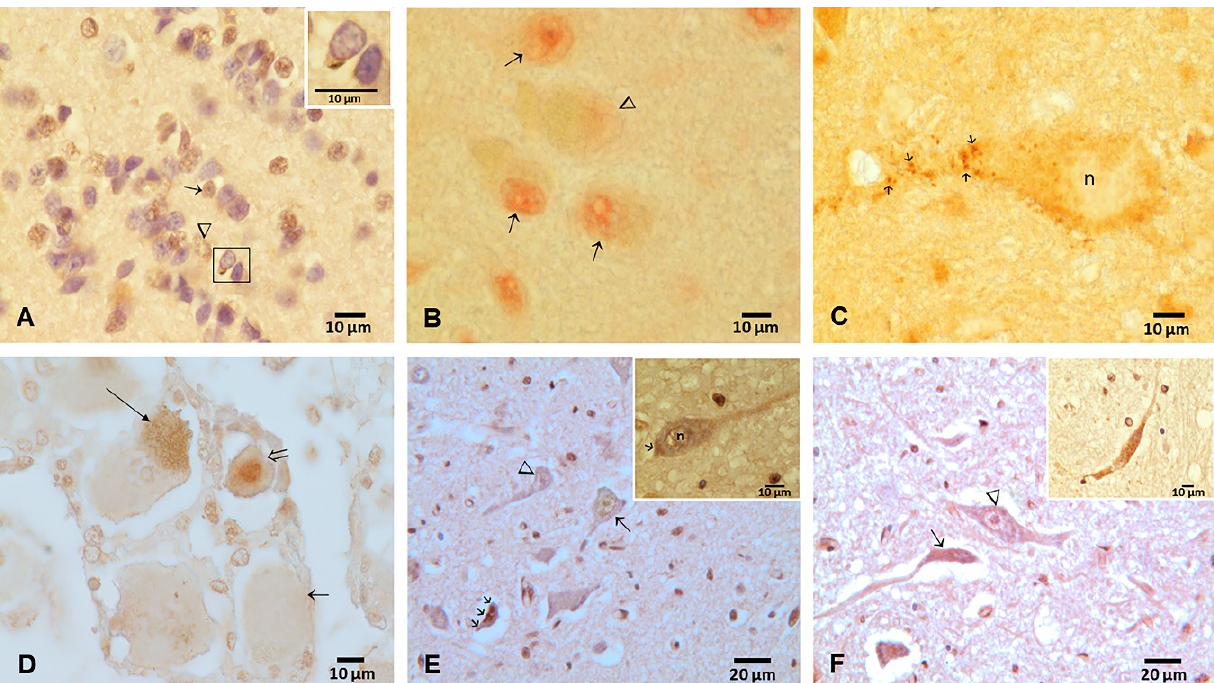
Figure 4. Olfactory bulb, trigeminal ganglia and brainstem motor nuclei immunohistochemistry for TDP-43 in young Metropolitan Mexico City residents. ( A ) Olfactory bulb granule cells in a 25 y old male showing complete loss of nuclear TDP-43 IR (arrowhead) alternating with nuclear TDP-43 (short arrow), the presence of short tangles and loss of nuclear expression (square and insert, the arrow points to a short TDP-43 positive tangle in a granule neuron). TDP-43 and DAB (brown staining). ( B ) Oculomotor nucleus (III cranial nerve) in the 16 y old showing a neuron (arrowhead) with complete loss of nuclear IR surrounded by three neurons with strongly stained red nuclei (short arrows). ( C ) 40 y old male trigeminal spinal neurons with negative nuclei and cytoplasmic dash-like IR, mostly in the axonal region (short arrows). ( D ) 45 y old male trigeminal ganglia neurons with negative nuclei and cytoplasmic positivity (long arrow), alternating with negative nuclear IR (short arrow) and strong nuclear TDP-43 IR (arrowhead). ( E ) 16 y male vagal neurons with negative nuclei (arrowhead), neurons with weak nuclear IR (long arrow) and neurons with intense cytoplasmic inclusions (three short arrows). DAB, brown product. Insert: Vagal neuron with a negative nucleus (n) and positive cytoplasmic IR (short arrow). ( F ) 16 y old male hypoglossal neurons with negative IR nuclei (arrowhead) alongside a neuron with intense cytoplasmic IR (arrow). Insert. hypoglossal neuron with intense IR granular material. DAB, brown product.